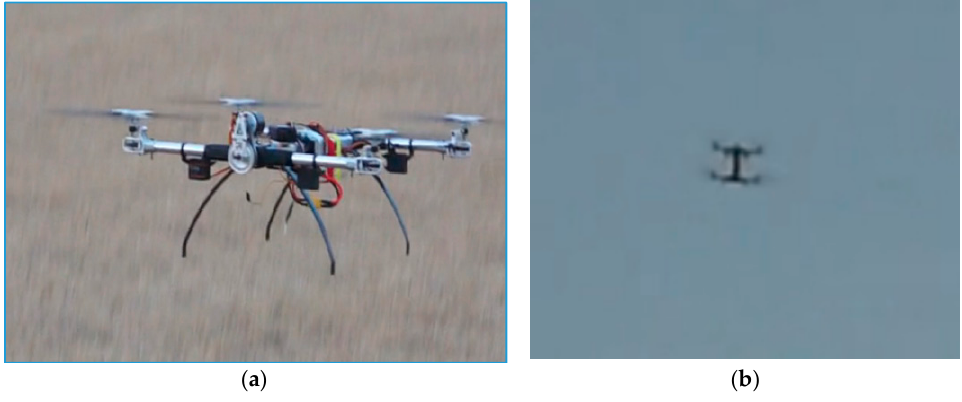
Figure 6. Experimental test scenes: ( a ) take-off flight; ( b ) climb and descent flights.